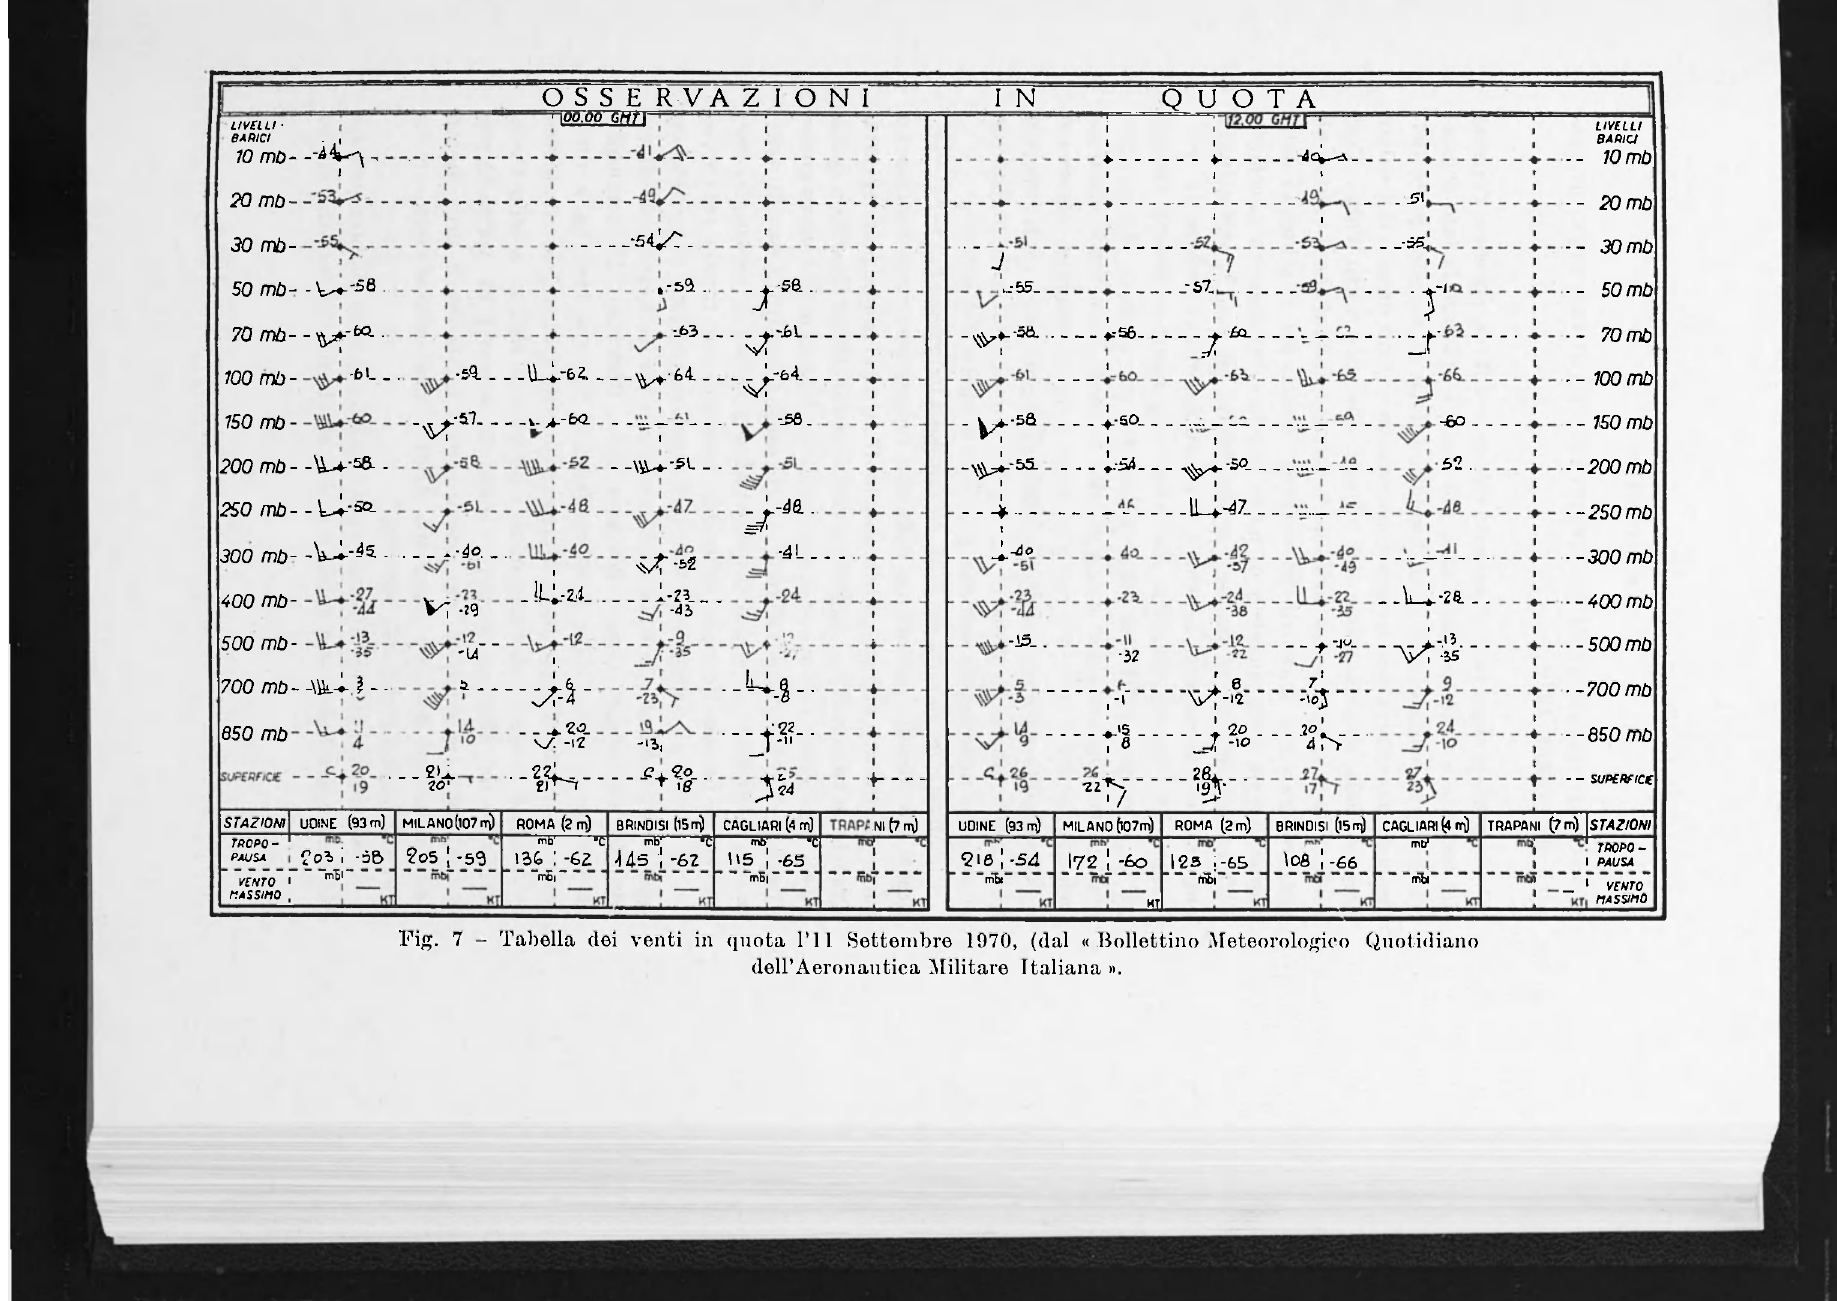
Fig. 7 - Tabella (lei venti in quota l'il Settembre 1970, (dal « Bollettino Meteorologico Quotidiano dell'Aeronautica Militare Italiana